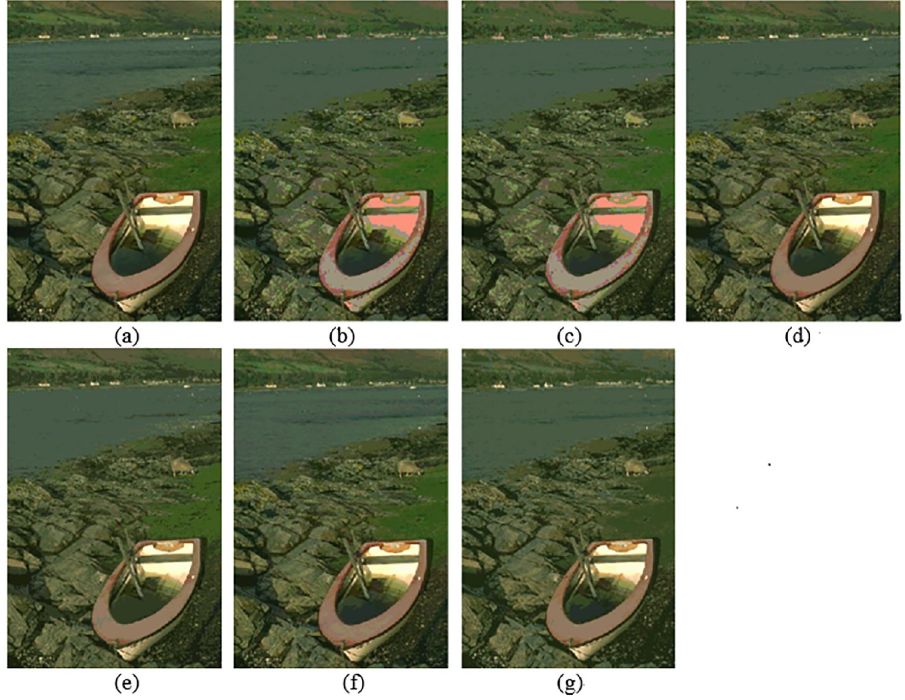
Fig 7. The image Marsh : (a) original image, (b, c) initial segmented result and result after region merging based on the histon, (d, e) initial segmented result and result after region merging based on the roughness index, (f, g) initial segmented result and result after region merging based on AHHT